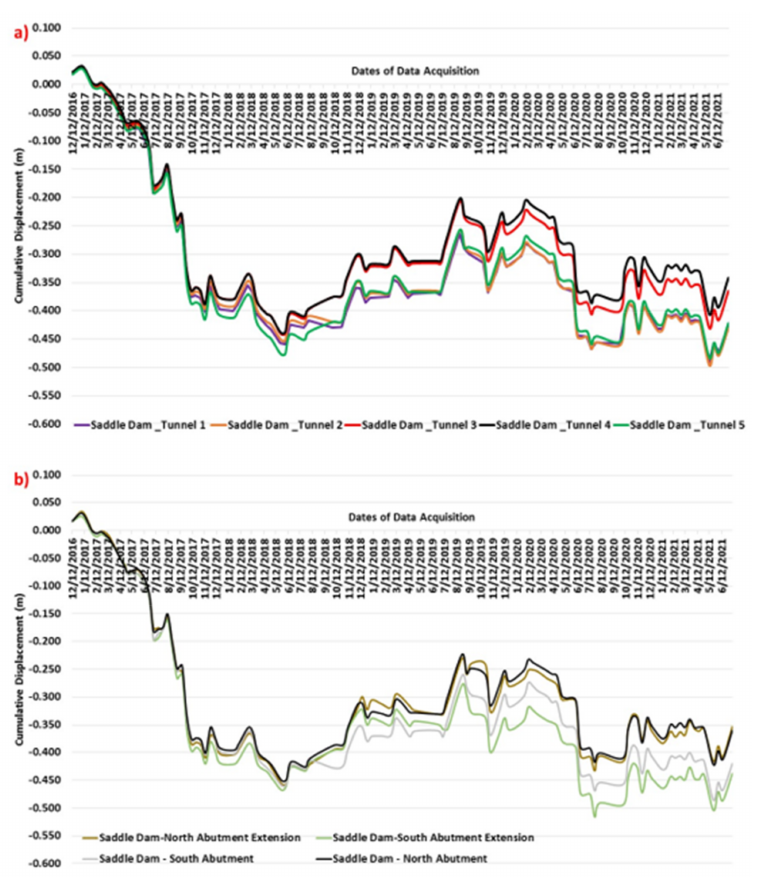
Figure 6. Observed vertical displacement over the GERD’s Saddle Dam at ( a ) tunnels 1 to 5, ( b ) North and South abutment and their